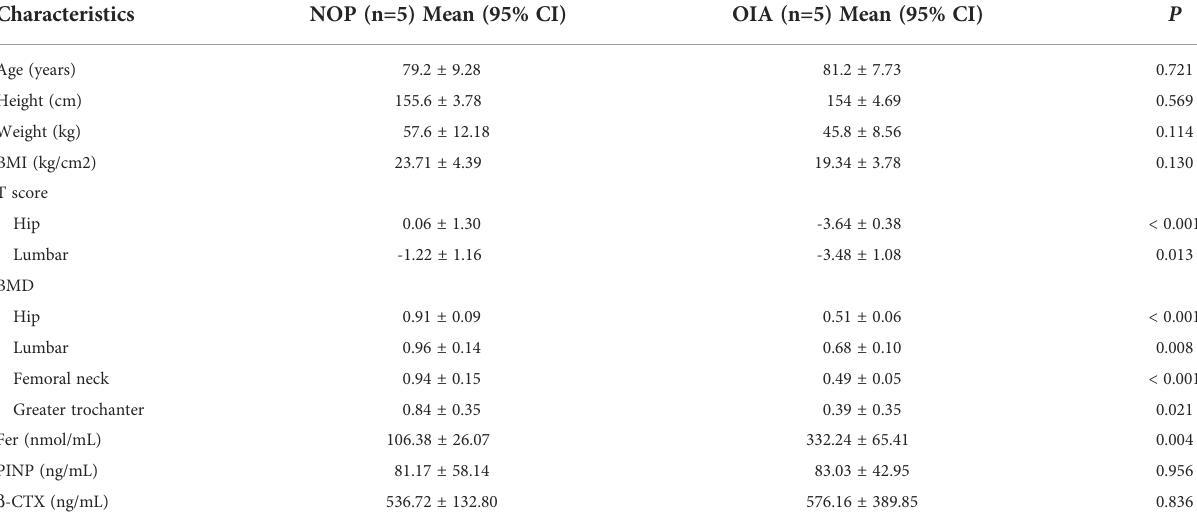
TABLE 1 Baseline characteristics of the patients in our cohort.